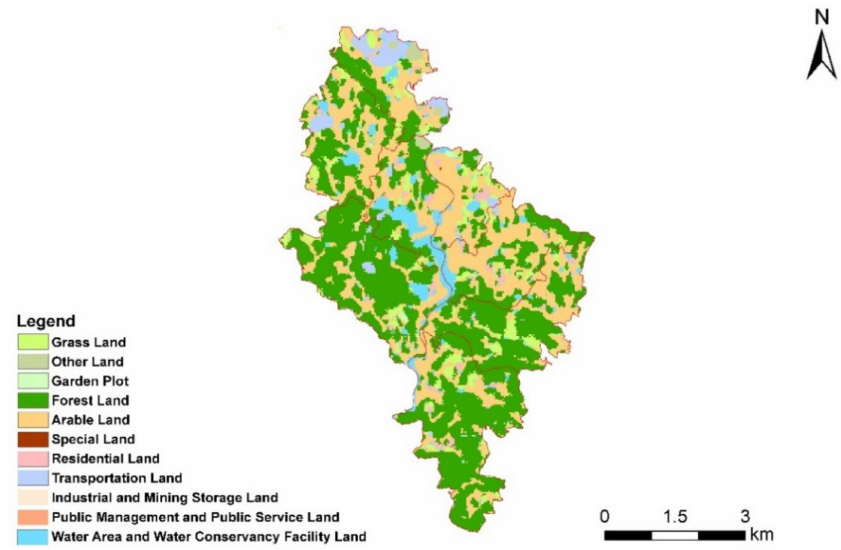
Figure 6. Simulation of land use results in 2030.